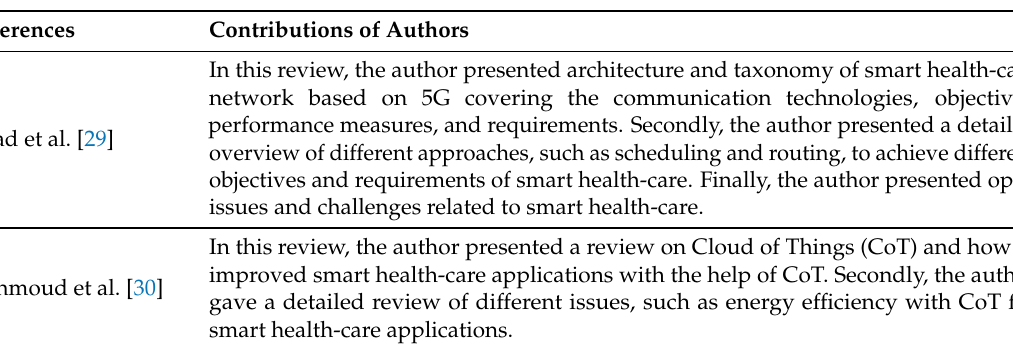
Table 1. Existing survey on smart